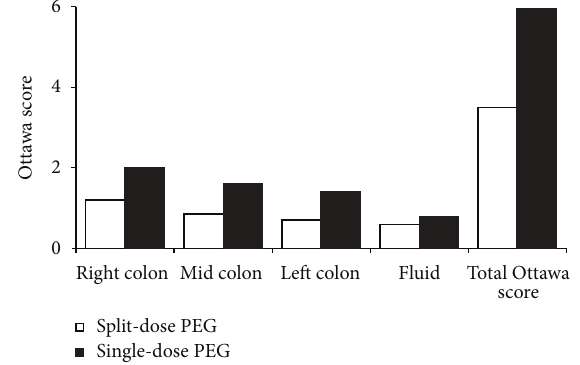
Figure 1: Ottawa Bowel Prep scores for split-dose and single-dose PEG lavage groups by colon segment and overall. Lower scores are better.